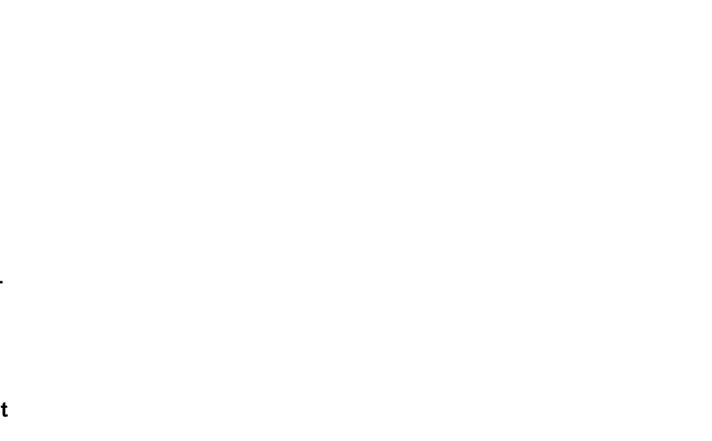
Figure 1. MTT assay screening of crude extracts from A. muricata leaves extracted using hexane, ethyl acetate, and methanol.